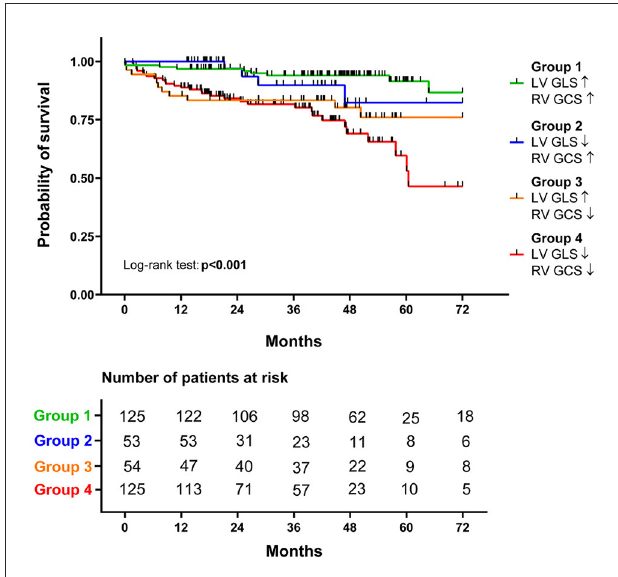
FIGURE2 Survival analysis of the different groups. Based on the respective median values of left ventricular global longitudinal strain (LV GLS, − 15.9%) and right ventricular global circumferential strain (RV GCS, − 17.9%), patients were divided into four groups. The survival of the four groups is visualized on Kaplan-Meier curves, and the log-rank test was performed for